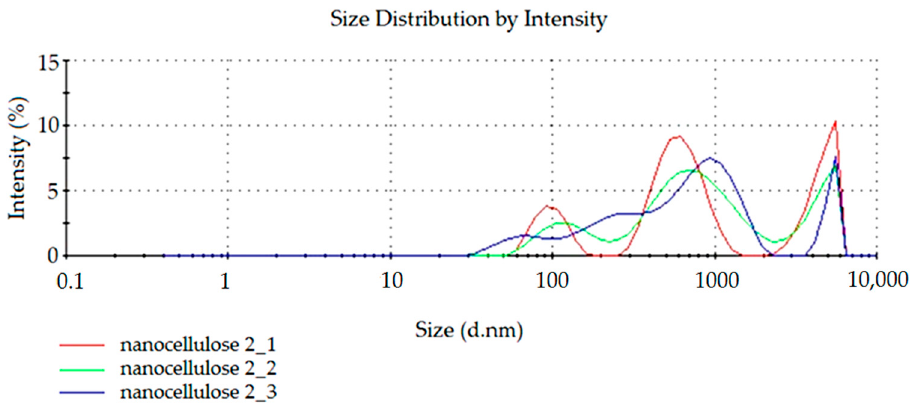
Figure 3. The spectrum of dependence of particle intensity on particle size.